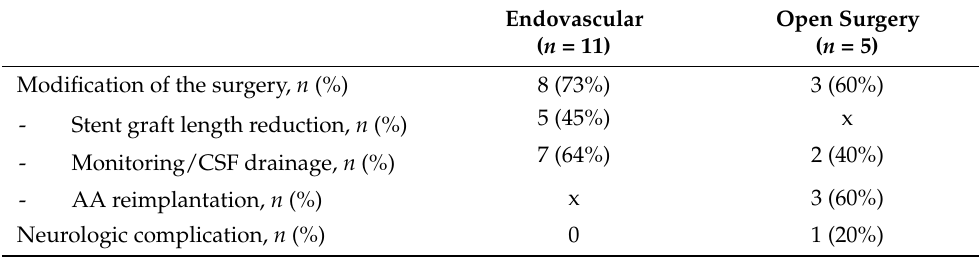
Table 4. Procedure modifications following presurgical identification of the AA for both endovascular and open surgery treatments and neurological complication follow-up ( n = 16). CSF: cerebrospinal fluid; AA: Adamkiewicz